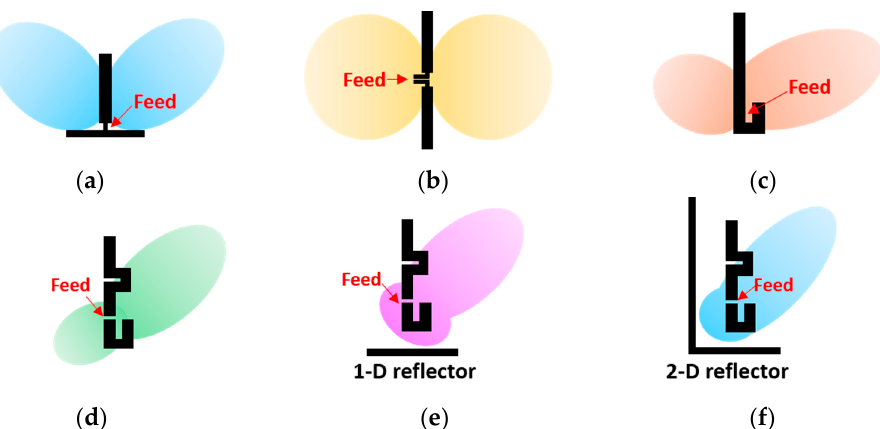
Figure 2. Di ff erent types of potential antennas for UAV-mounted sensor: ( a ) monopole, ( b ) dipole, ( c ) J-pole, ( d ) super J-pole, ( e ) super J-pole with a 1D reflector, and ( f ) super J-pole with a 2D reflector.